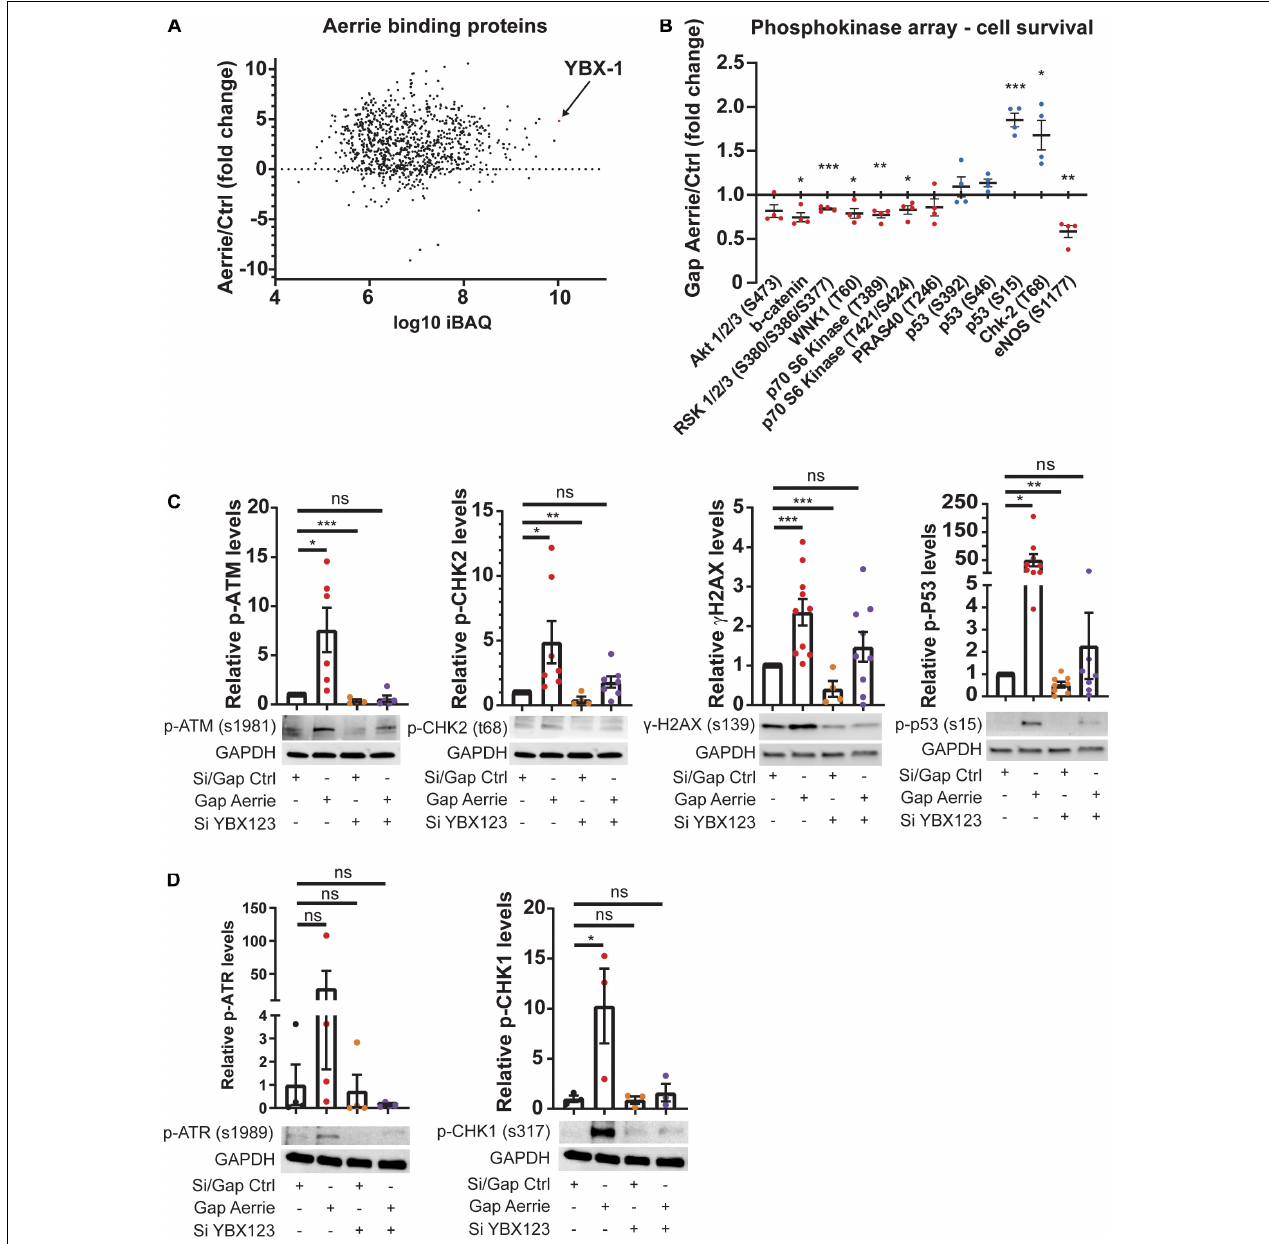
FIGURE 3 | Interaction of Aerrie with YBX1 is important for DNA damage signaling. (A) Aerrie-interacting proteins identified by mass spectrometry of RNA-antisense purifications in HUVECs. Identified proteins are plotted against respective IBAQ values. (B–D) HUVECs were treated with gapmeR (gap) targeting Aerrie, siRNA (si) targeting YBX1/2/3 or a respective control. (B) Phosphokinase levels of cell survival-related proteins ( n = 4). Red dots are defined as the average level of phosphorylation after silencing knockdown is decreased compared to its respective control. Blue dots are defined as the average level of phosphorylation after silencing knockdown is increased compared to its respective control. (C) Phosphorylation levels of activated proteins in the double-strand break repair pathway were analyzed by western blotting. Phosphorylated ATM at serine 1981, CHK-2 at tyrosine 68, H2AX at serine 139, and P53 at serine 15 were analyzed upon depletion of Aerrie and YBX1 ( n > 4). (D) Phosphorylation levels of activated proteins in the single-strand break repair pathway were analyzed by western blotting. Phosphorylated ATR at serine 1989, CHK-1 at serine 317 were analyzed upon depletion of Aerrie and YBX1 ( n = 3). * p < 0.05; ** p < 0.01; *** p < 0.001; ns , not statistically